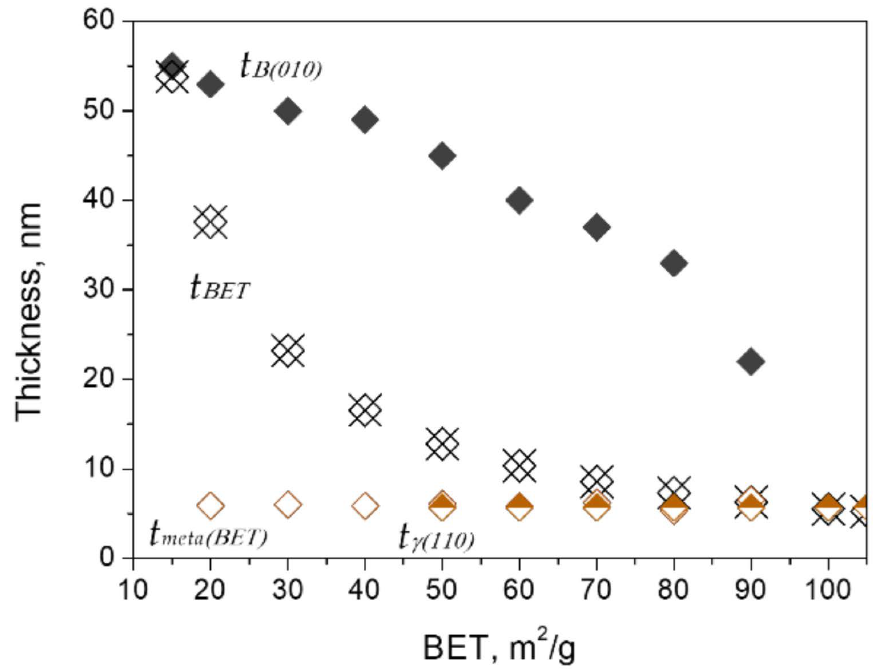
Figure 5. Variations of the average thickness of calcined boehmite samples ( t BET ) and flakes of